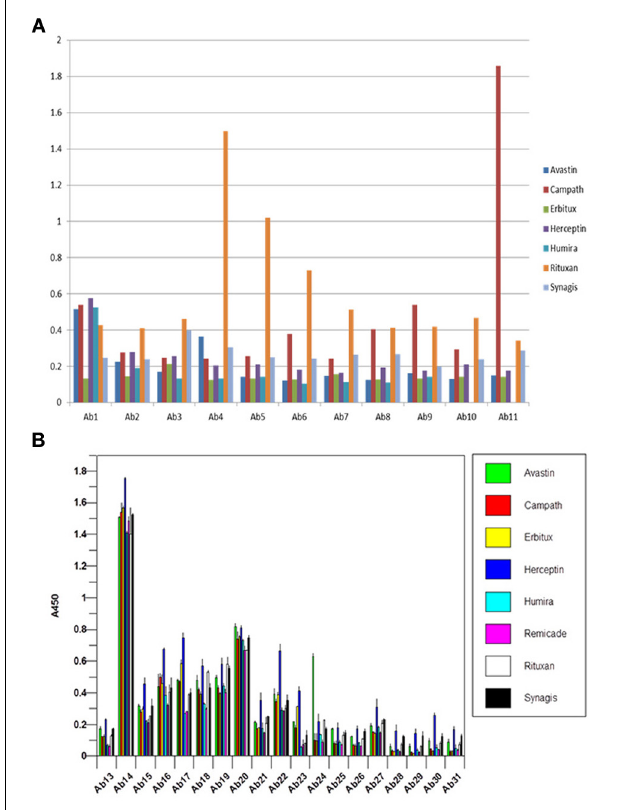
FIGURE 5 | (A) Antibody array ELISA analysis of seven marketed mAbs, variable region. Seven mAbs on the market were tested for their surface epitope exposure using specific antibody sets prepared against the corresponding mAb variable region. (B) Antibody array ELISA analysis of seven marketed mAbs, constant region. Because all the mAbs on the market have highly homologousconstant region with more than 95% amino acid identity, a single set of antibody raised against Herceptin constant region was used for the analysis of surface epitope exposure of all the seven mAbs on the